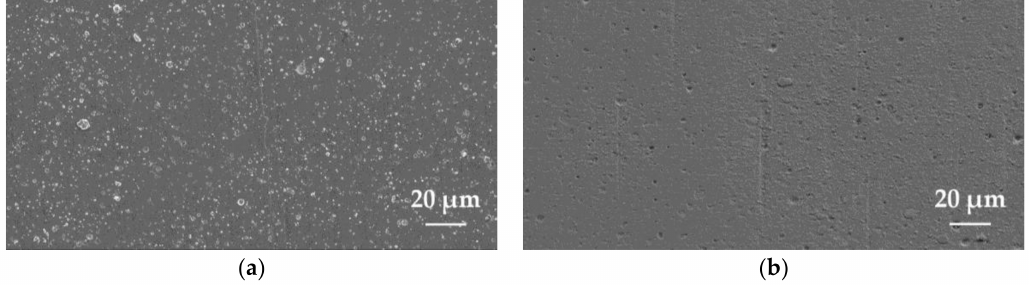
Figure 7. The surface of the TiCN-MP coating identified via SEM: ( a ) After coating; ( b ) after drag grinding.